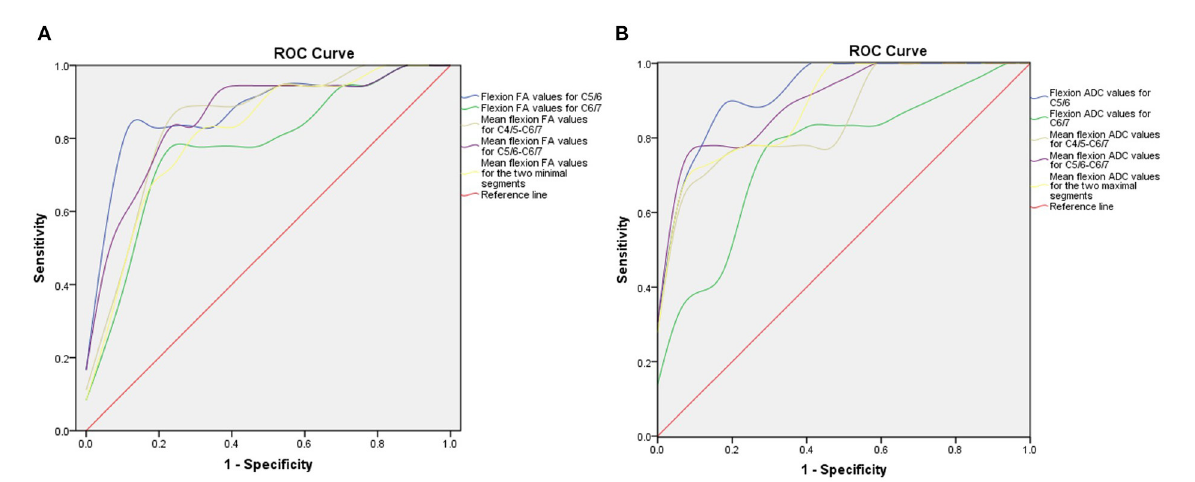
FIGURE5 ROC curve for preoperative DTI parameters. (A) ROC curve of preoperative FA values in the flexion position. (B) ROC curve of preoperative ADC value in the flexion position. ROC, receiver operating characteristic; DTI, diffusion tensor imaging; FA, fractional anisotropy; ADC, apparent diffusion coefficient.